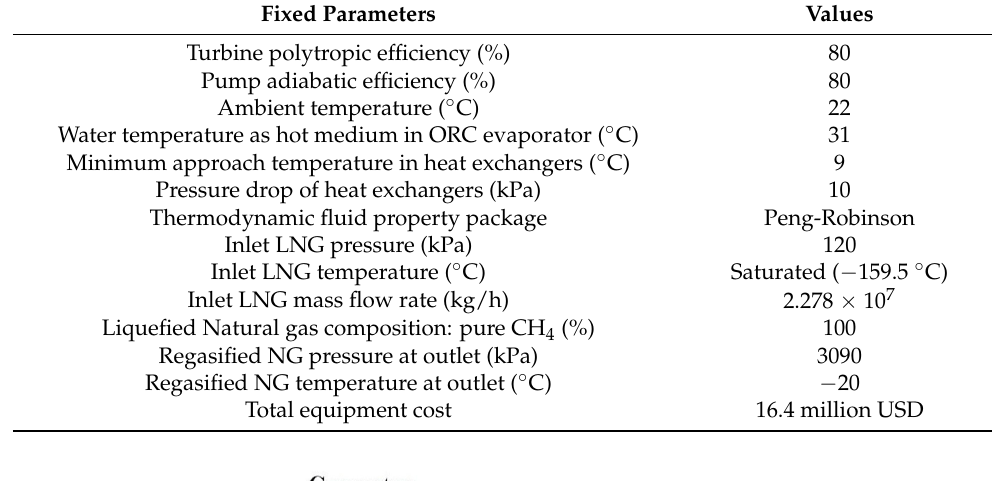
Table 1. Detail of the fixed parameters used for simulation of LNG regasification process-ORC-ANSU energy system.